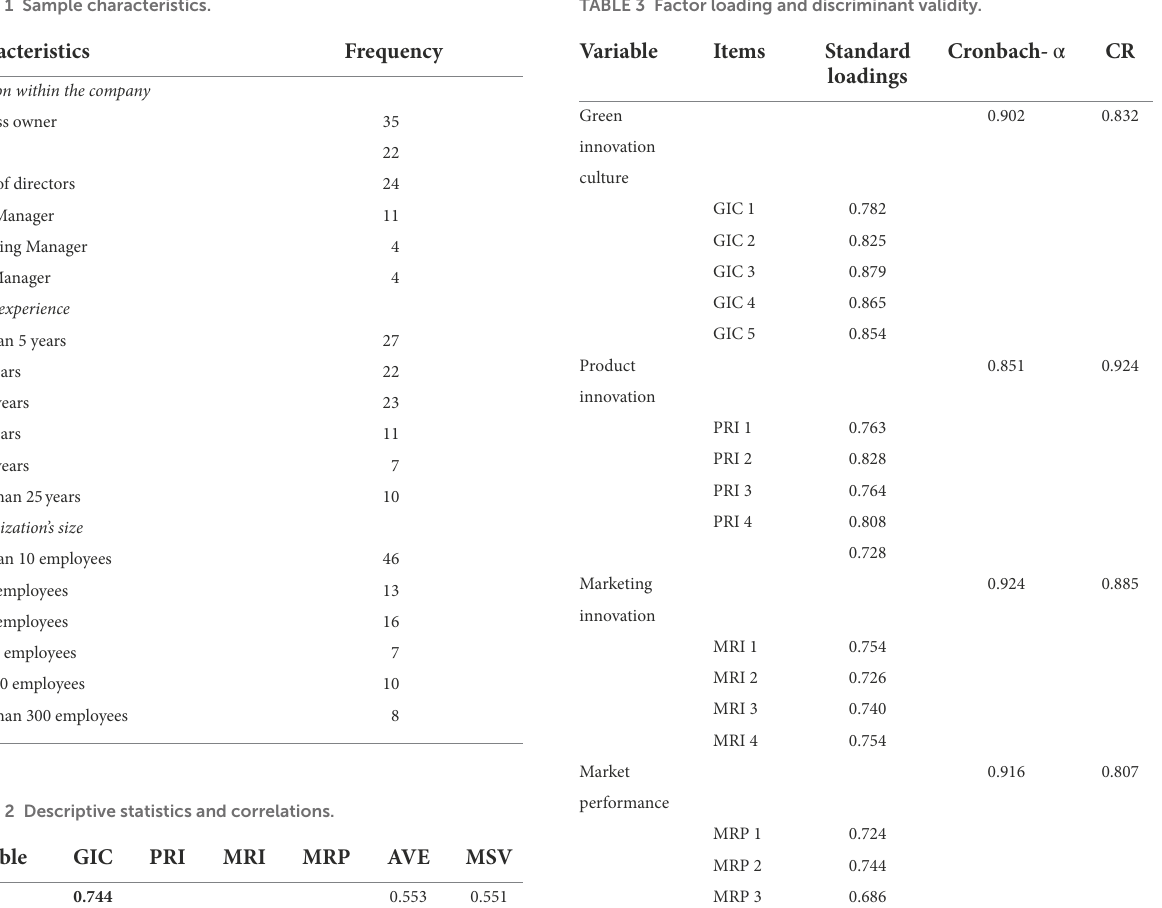
TABLE 1 Sample characteristics.